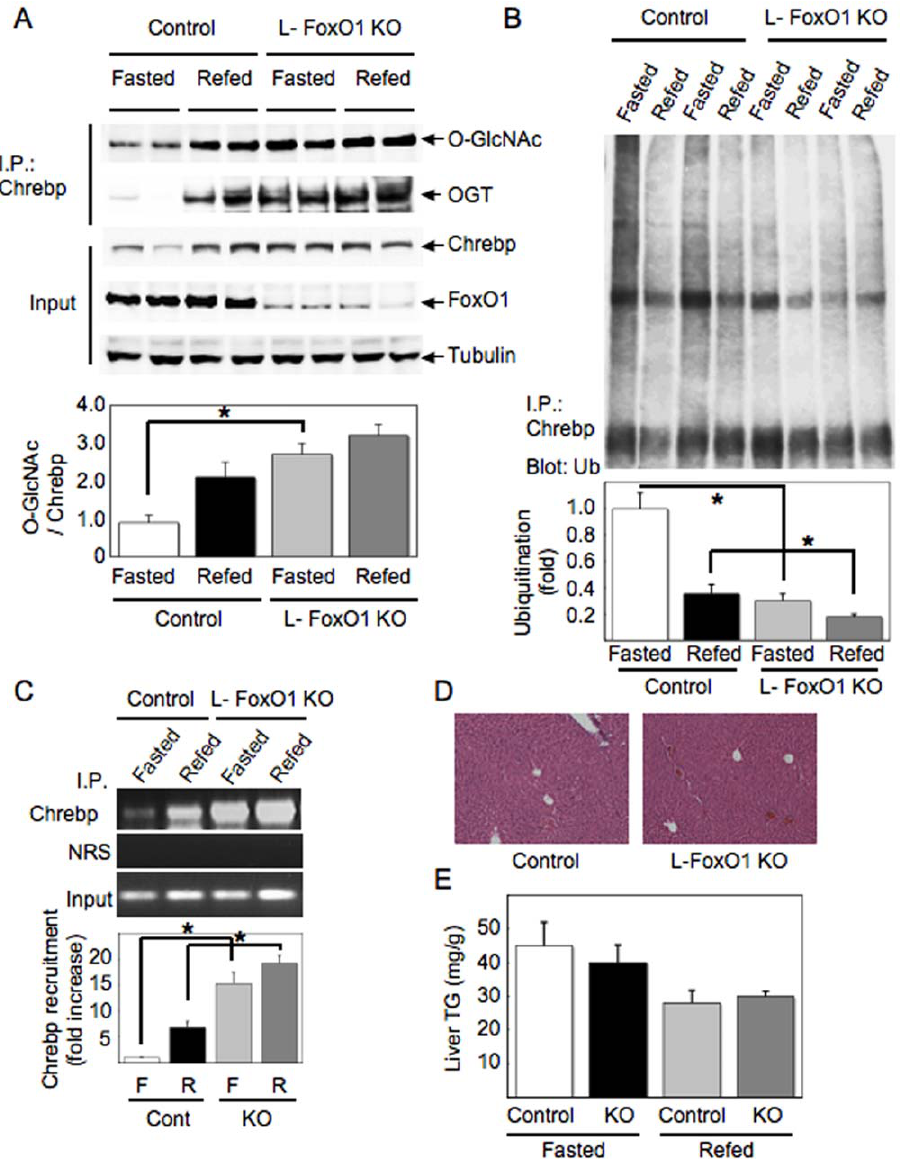
Figure 3. Chrebp O-glycosylation, protein stability, and recruitment to the L-PK promoter are increased in FoxO1 knockout liver. (A and B) The liver samples isolated from L-FoxO1-KO and the control mice at the points of 24 hr fasted or 3 hr refed after 24 hr starvation were subjected to immunoprecipitation with anti-Chrebp antibody followed by blotting with anti-O-GlcNAc, anti-OGT (A) or anti-ubiquitin antibody (B). Input indicates the expression levels of Chrebp, FoxO1 or tubulin. Quantitative analyses were performed by assessment of O-glycosylation (A) or ubiquitination (B) levels compared with the protein level of Chrebp using densitometry, showing as a bar graph below the results of blotting. (C) The liver extracts were also subjected to chromatin immunoprecipitation assay using anti-Chrebp antibody and primers for the L-PK promoter. Quantitative analyses were performed using densitometry. Input indicates extracted DNA prior to immunoprecipitation. Experiments were repeated at least three times. Data represent mean 6 SEM. *P , 0.05. (D) Hematoxylin-and-eosin (H-E) staining of the liver sections from 24 hr fasted L-FoxO1- KO and the control mice. Magnification, x100. (E) Hepatic triglyceride (TG) contents in 24 hr fasted or 3 hr refed (after 24 hr starvation) L-FoxO1-KO and the control mice (n=6 for each group). Data represent mean 6